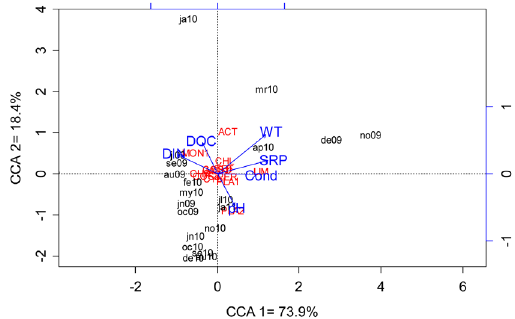
Figure 7. Canonical correspondence analysis (CCA) showing the ordination of the phytoplanktonic species in relation to the limnological variables. Abbreviations used: